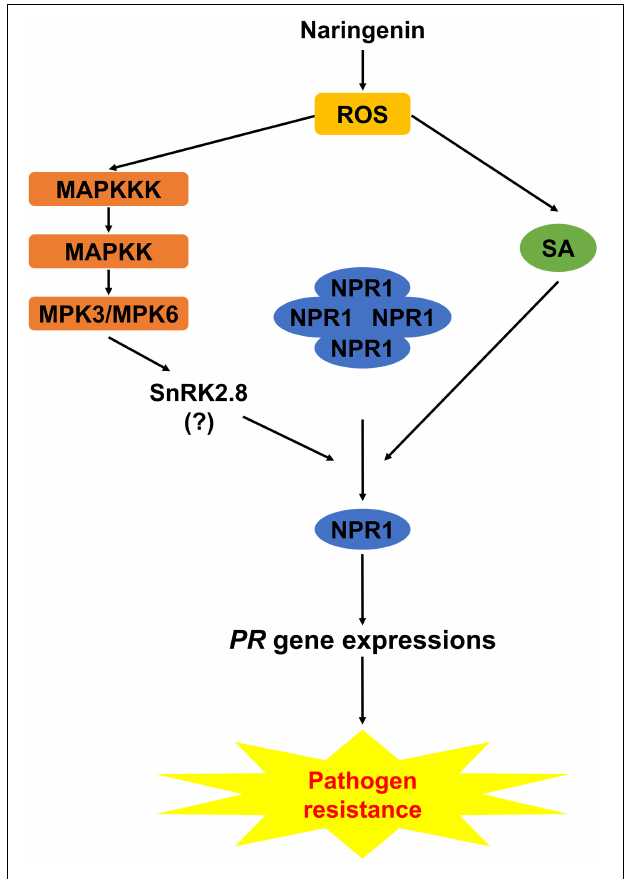
FIGURE 9 | Working model explaining how naringenin induces pathogen resistance. Naringenin activates the production of ROS in plants. In SA-dependent pathway, naringenin activates the monomerization and nuclear translocation of NPR1 by the accumulation of SA. In SA-independent pathway, naringenin activates MPKs, and the activated MPKs possibly activate SnRK2.8 that promotes the monomerization and nuclear translocation of